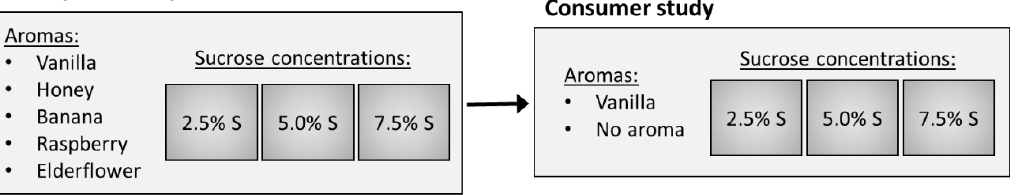
Figure 1. Overview of the samples in the descriptive analysis and the consumer study. % S = % w/w sucrose.